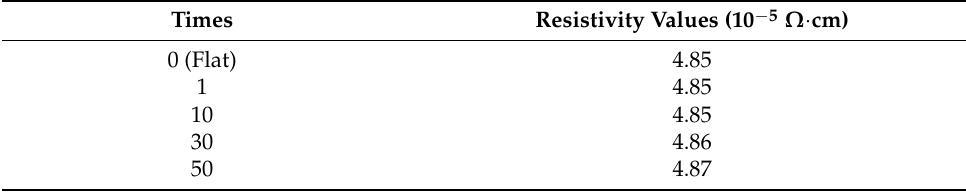
Table 4. Resistivity values of the films under the flat and different times of folding.